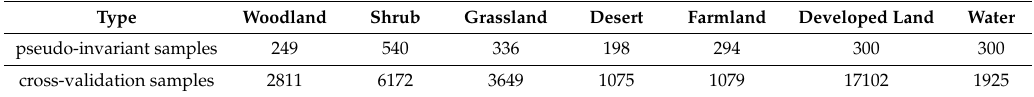
Table 1. Pseudo-invariant samples and cross-validation samples.